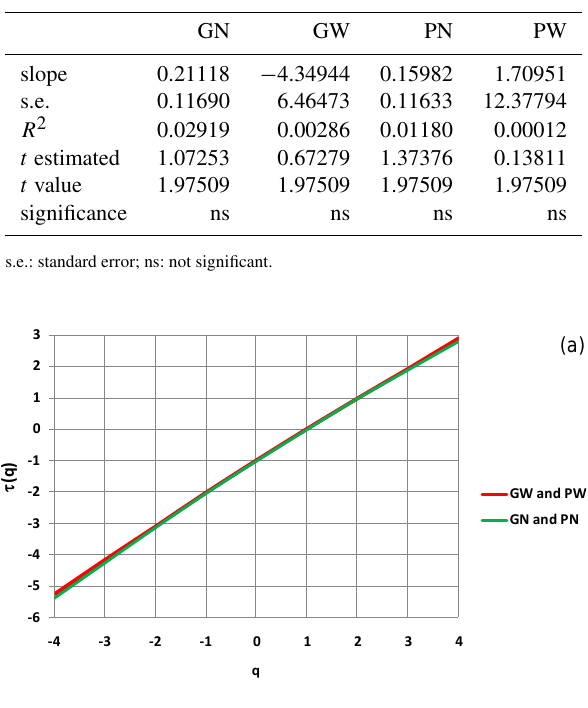
Table 3. Statistical trend significance between the variables studied and the distance in the transect (see Fig. 3): grain N content (GN), grain weight (GW), wheat N content (PN) and wheat weight (PW).